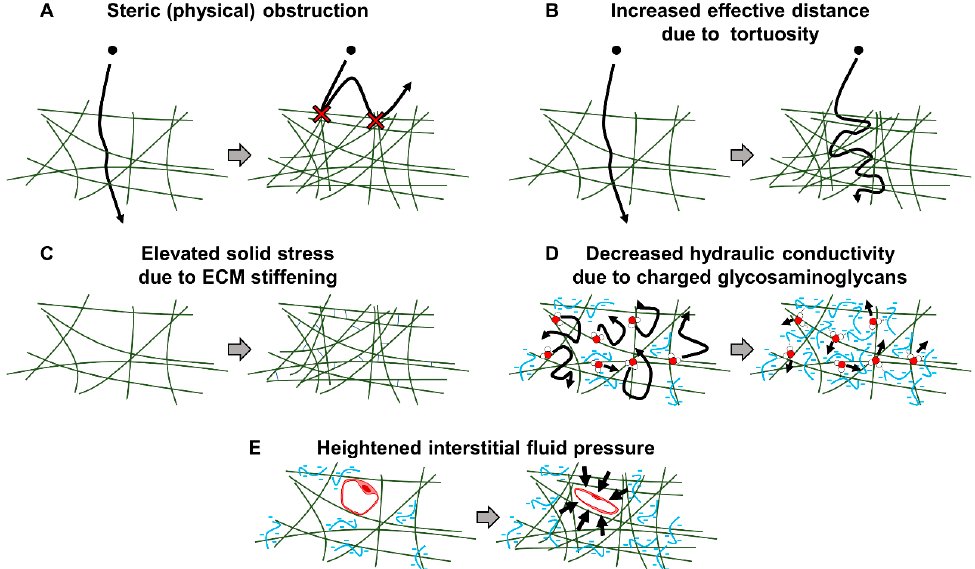
Figure 8. The ECM barrier to nanomedicine delivery. The ECM poses a barrier to nanomedicine delivery via various mechanisms. ( A ) The ECM can sterically obstruct nanomedicine passage. ( B ) The increased deposition of ECM as well as its compression from neighboring cells increases the tortuosity of the ECM network. This results in an increased effective distance a nanomedicine must travel to locate a tumor target. ( C ) Cross-linking causes stiffening of the ECM network which elevates solid stress. ( D ) Negatively charged glycosaminoglycans such as hyaluronan trap water and reduce hydraulic conductivity. ( E ) Increased ECM deposition and trapped water result in elevated interstitial fluid pressure which causes vascular compression/collapse.